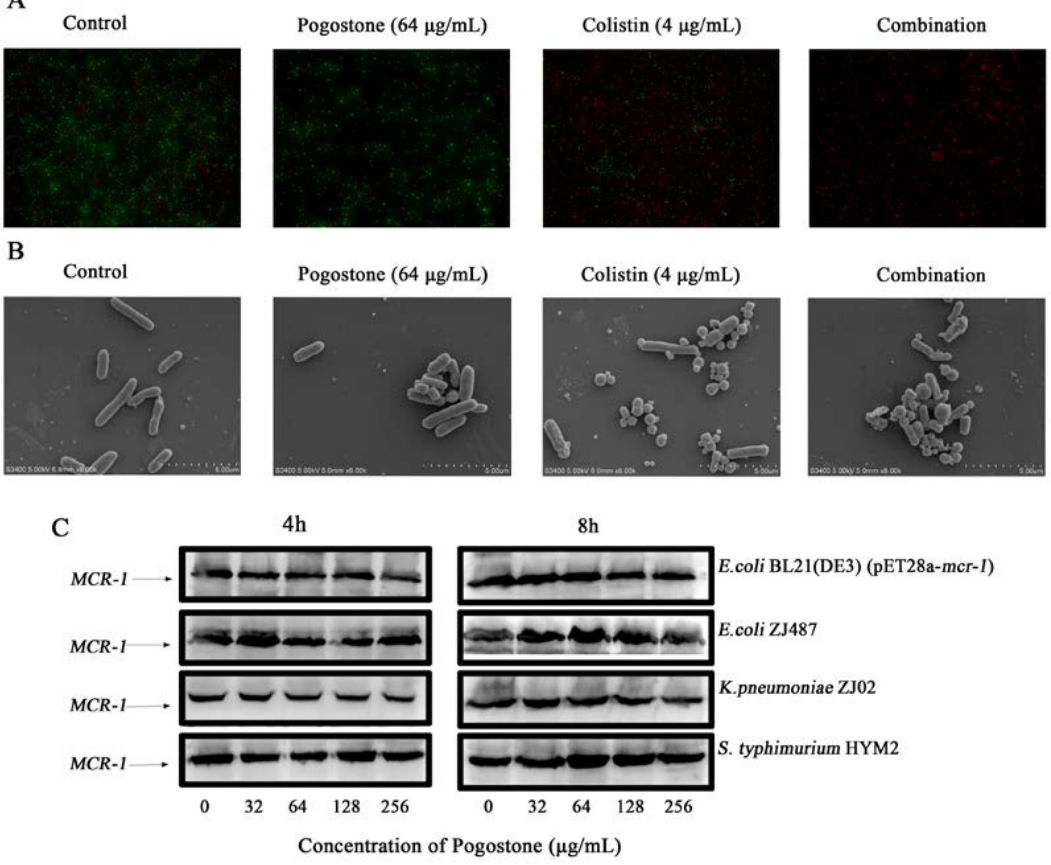
Figure 3. ( A ) Staining of live (green) and dead (red) bacteria. ( B ) The morphology of E. coli BL21 (DE3) (pET28a- mcr-1 ) observed by SEM. ( C ) MCR-1 production in E. coli BL21 (DE3) (pET28a- mcr-1 ), E. coli ZJ487, K. pneumoniae ZJ02 and S. typhimurium HYM2 treated with the indicated concentrations of pogostone (0, 32, 64, 128, or 256 µ g/mL) by western blot